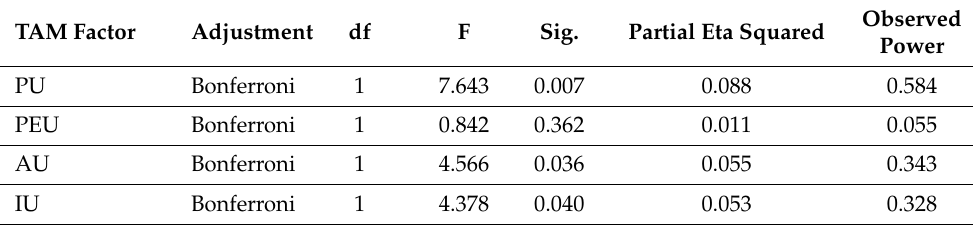
Table 13. Tests of between-subjects effects per individual TAM